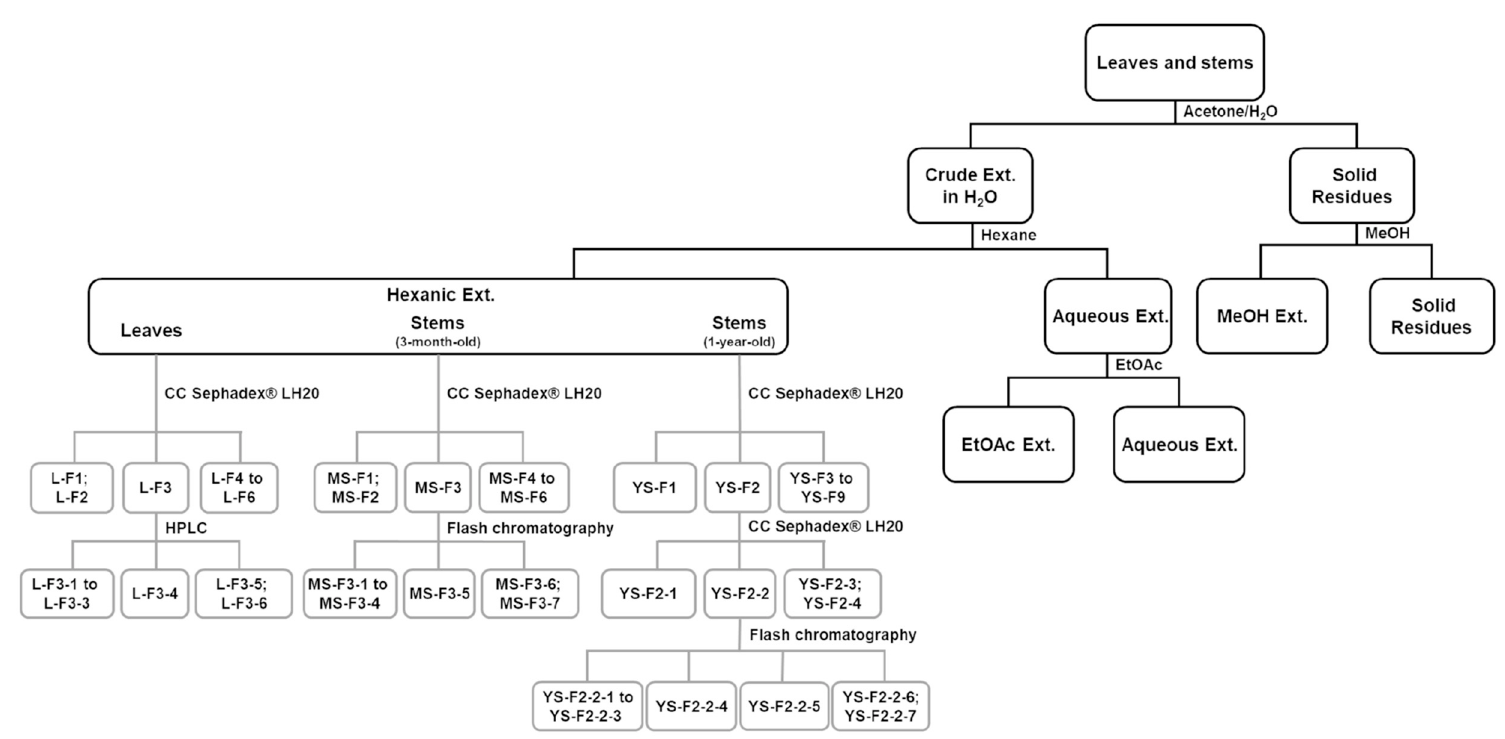
Figure 1. Summary of extraction and fractionation steps of R. idaeus leaves and stems.